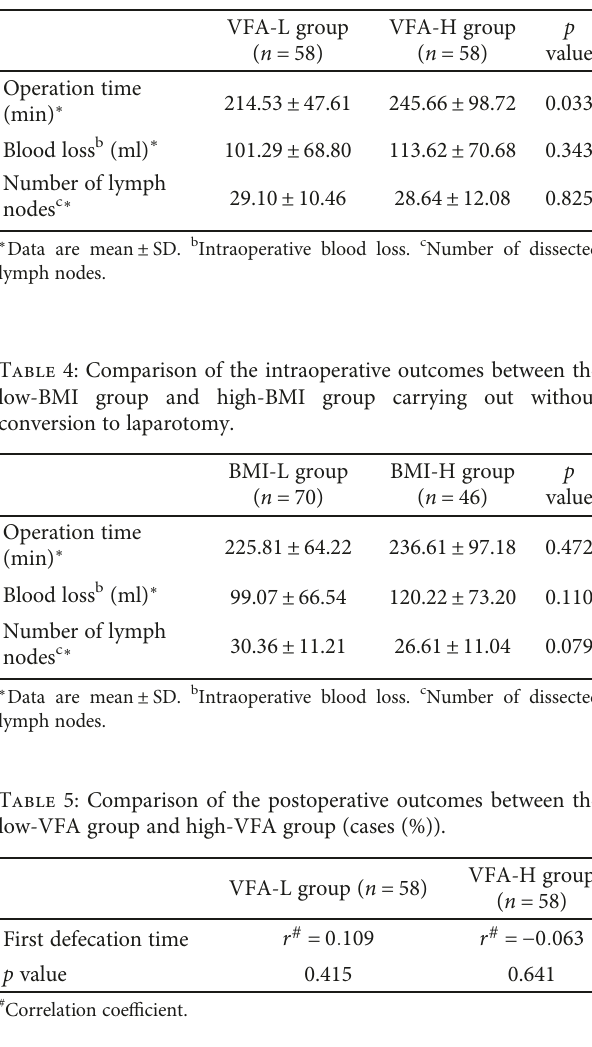
Table 3: Comparison of the intraoperative outcomes between the low-VFA group and high-VFA group carrying out without conversion to laparotomy.